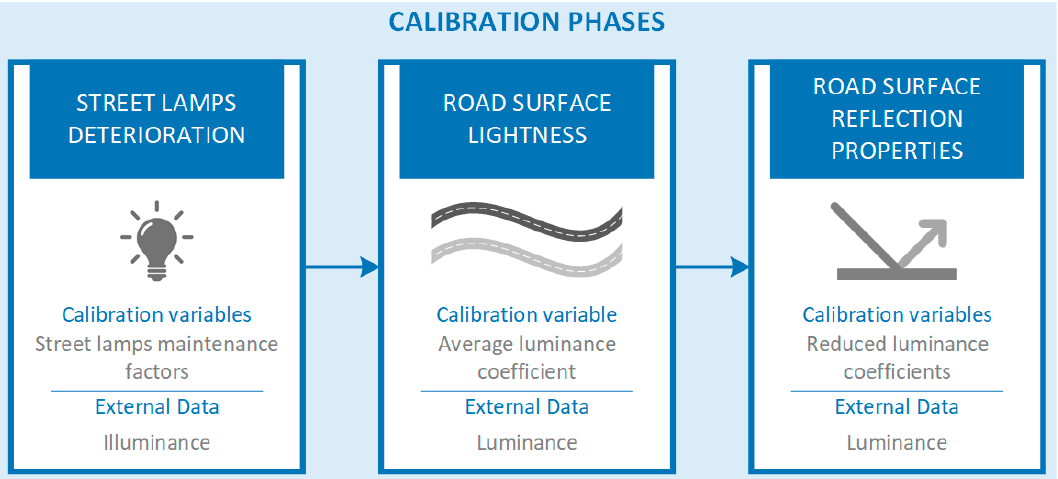
Figure 2. Stages of the calibration methodology: calibration variables and external data used for the error calculation.